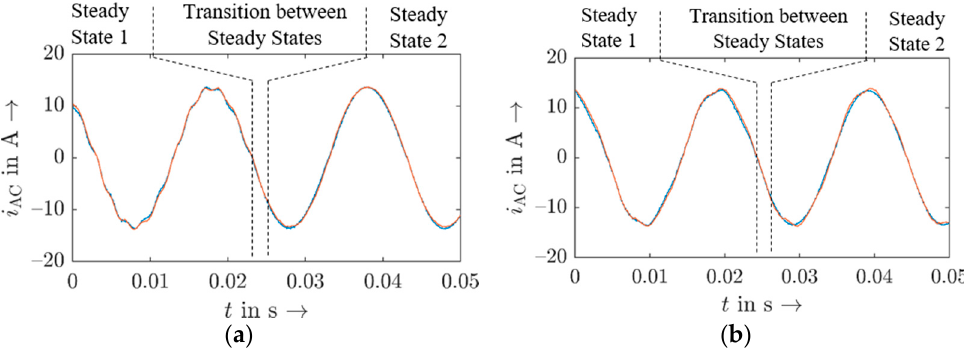
Figure 7. Measured grid-side current (red) and grid-side current simulated by ANN (blue) with ( a ) a single-frequent 500 Hz distortion in steady state 1 and ( b ) a multi-frequent distorted voltage u AC in steady state 1 and a sinusoidal voltage u AC in steady state 2.